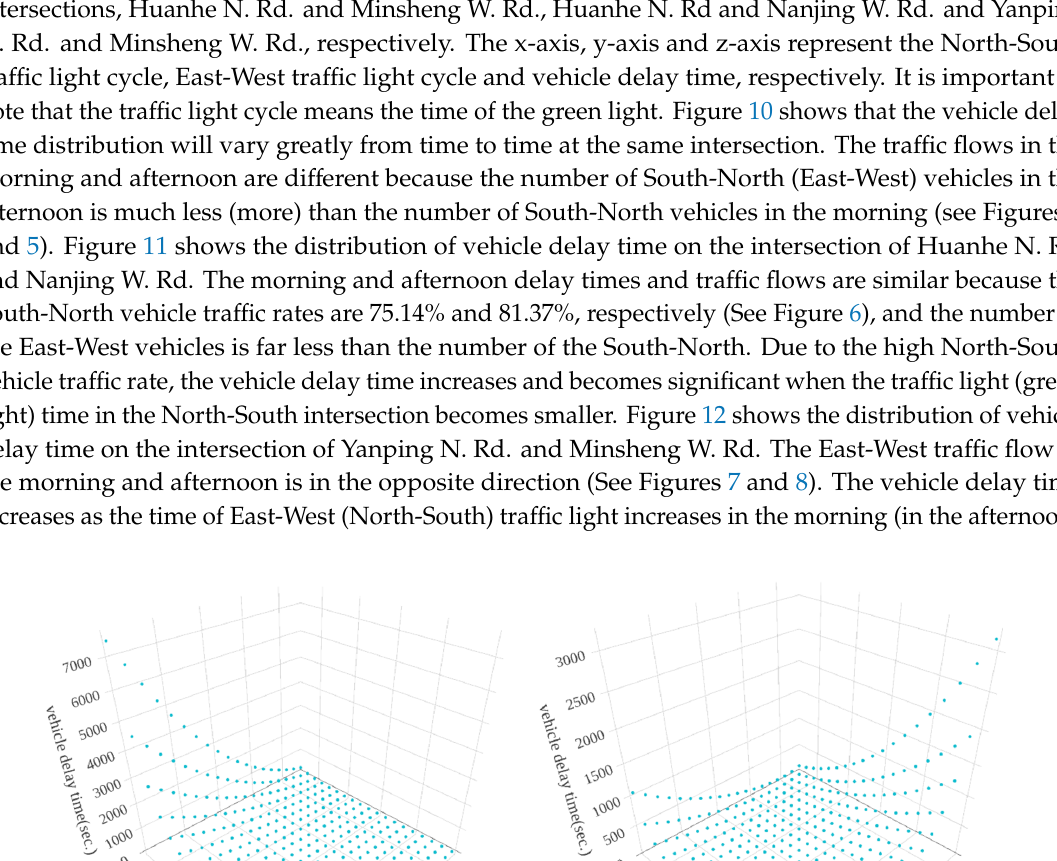
( b ) Figure 11. The results of vehicle delay by using exhaustive search method on Huanhe N. Rd and Nanjing W. Rd. ( a ) from 8:00 a.m. to 9:00 a.m. ( b ) from 5:00 p.m. to 6:00 p.m.